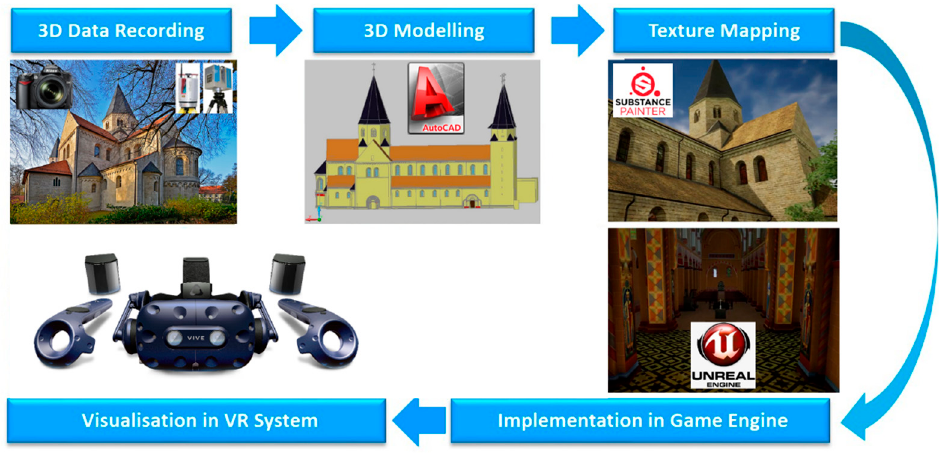
Figure 2. Workflow for the development of the virtual reality (VR) experience.